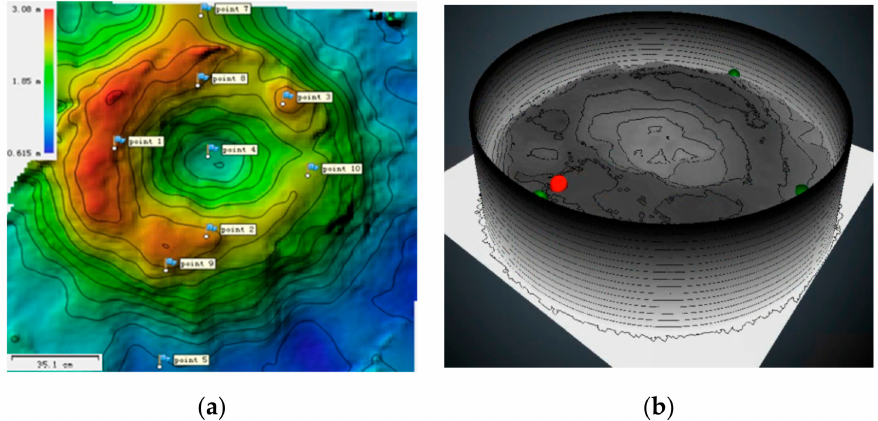
Figure 16. Result of 3D reconstruction. ( a ) Birdview topography 3D map. ( b ) 3D burden surface shape.